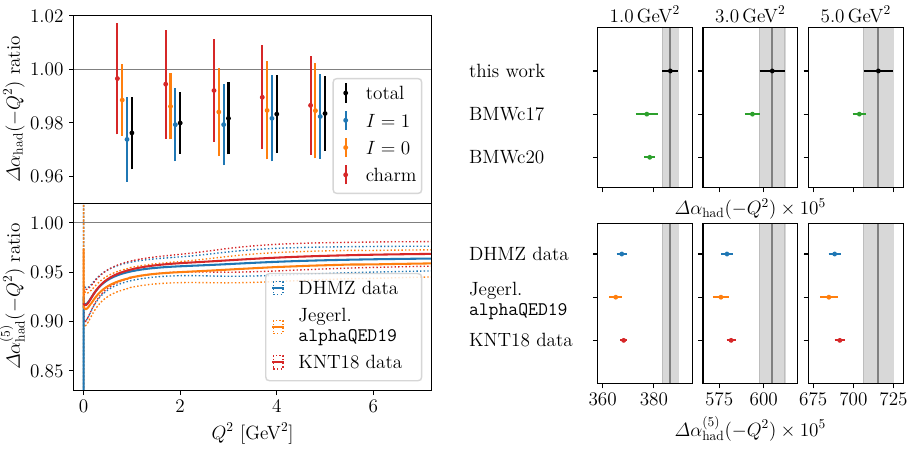
Figure 12 . Left, upper panel: ratio of the hadronic running ∆α had computed by BMWc [21] divided by our results, for five different momenta. In addition to the total contribution, we show the isovector ( I = 1 ), isoscalar ( I = 0 ) and charm quark components. Left, lower panel: the total hadronic running ∆α (5) from various phenomenological estimates [12, 31, 134] and the lattice result had of ref. [21], normalized by the result of this work. Right: compilation of results for the four-flavor ∆α had lattice computations [6, 21] (above) and the five-flavor ∆α (5) phenomenological estimates had (below) at selected values of Q 2 . The gray vertical error band for the result of this work includes the small bottom quark contribution as an additional systematic error, see section 5.1 for